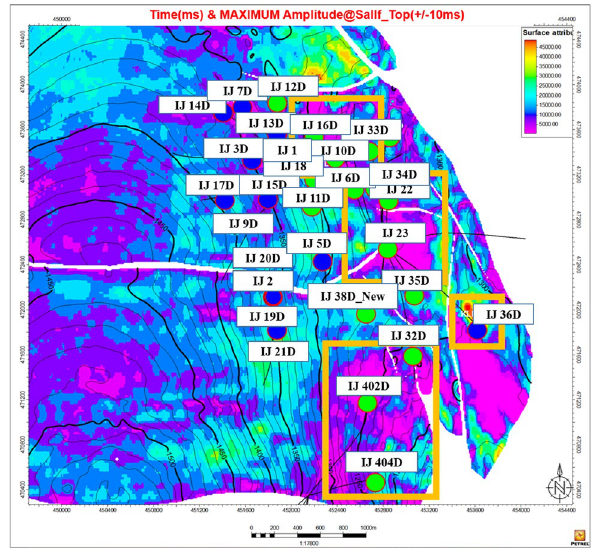
Fig. 10 Reservoir maximum amplitude map for SaIIf indicating a case of